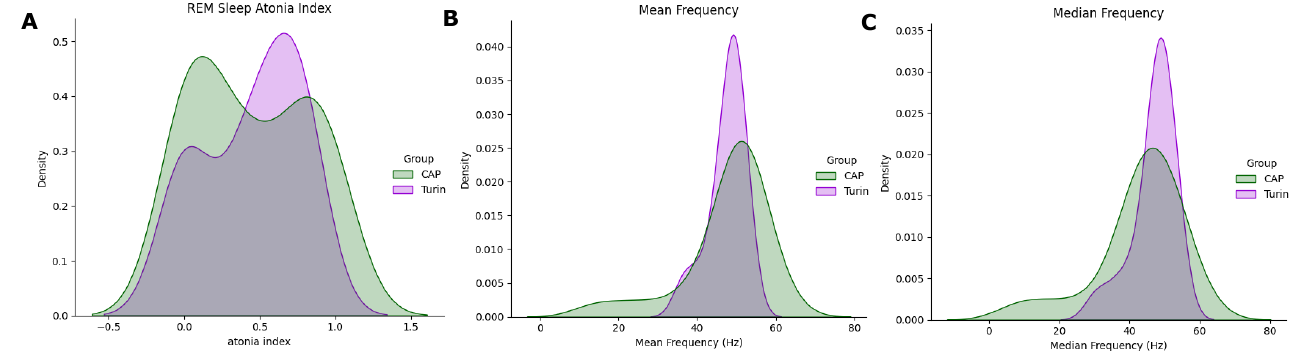
Figure 9. Distribution plots of three variables, computed in the CAP Sleep Database (green) and TURIN Database (purple). ( A ) RAI, ( B ) Mean Frequency, ( C ) Median Frequency.